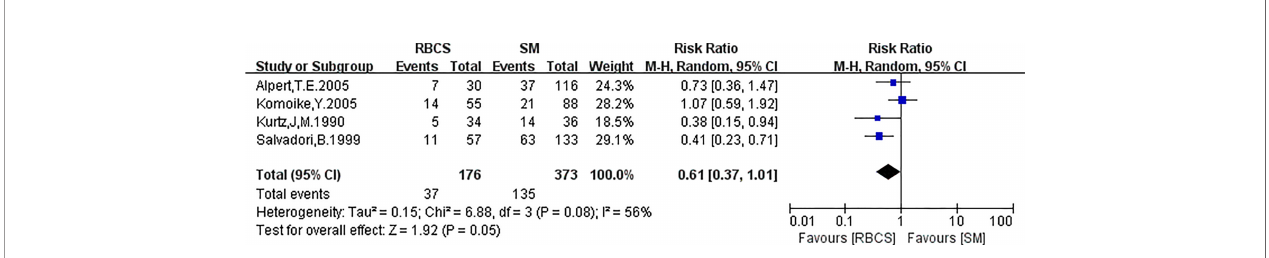
FIGURE 6 | Forest plot of repeated breast-conserving surgery (RBCS) versus salvage mastectomy (SM) after ipsilateral breast tumor recurrence (IBTR), comparing distant metastasis rate (DMR). The meta-analyse was performed with random effects model. RR more than 1 means the results favor SM group.